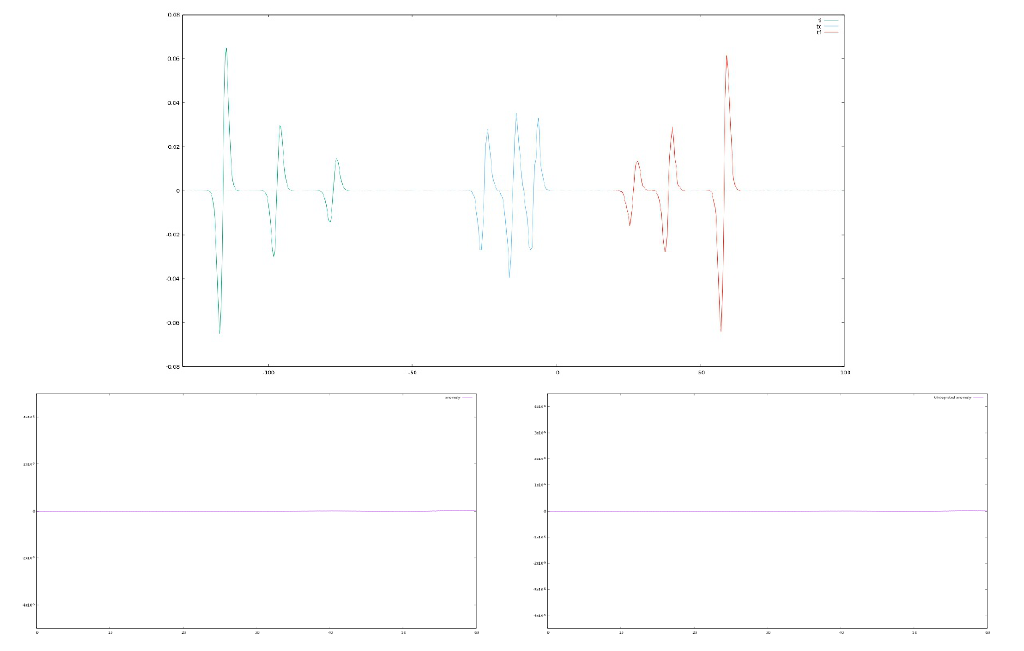
Figure 11 . Top (cid:12)gure shows the anomaly density of h 1 in (4.49); i.e. the function (cid:0) 4 q xxx (2 q 2 (cid:15) 2 q xx q tt ) plotted in x -coordinate for three successive times, t i = before collision (green), t c = collision (blue) and t f = after collision (red), for the 3-soliton of (cid:12)gure 3. Bottom (cid:12)gures show the plots of the anomaly h 1 vs. t and the t -integrated anomaly R t